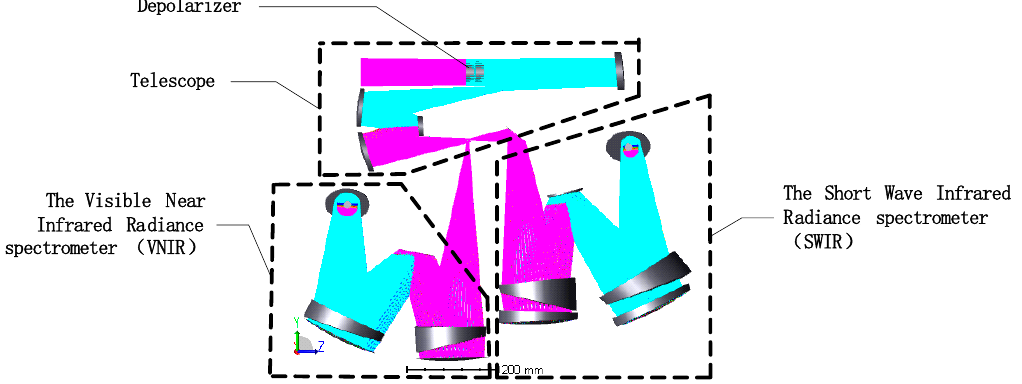
Figure 3. Optical design of the Earth–Moon Imaging Spectrometer (EMIS).